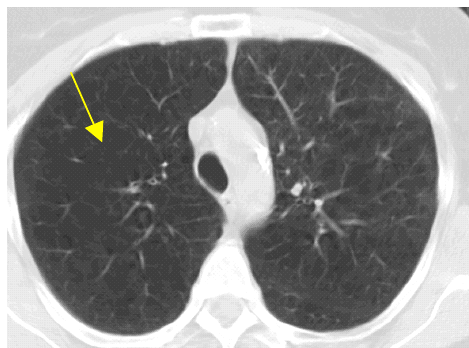
Figure 1 : A typical HRCT scan containing emphysema. The regions pointed by arrows denote